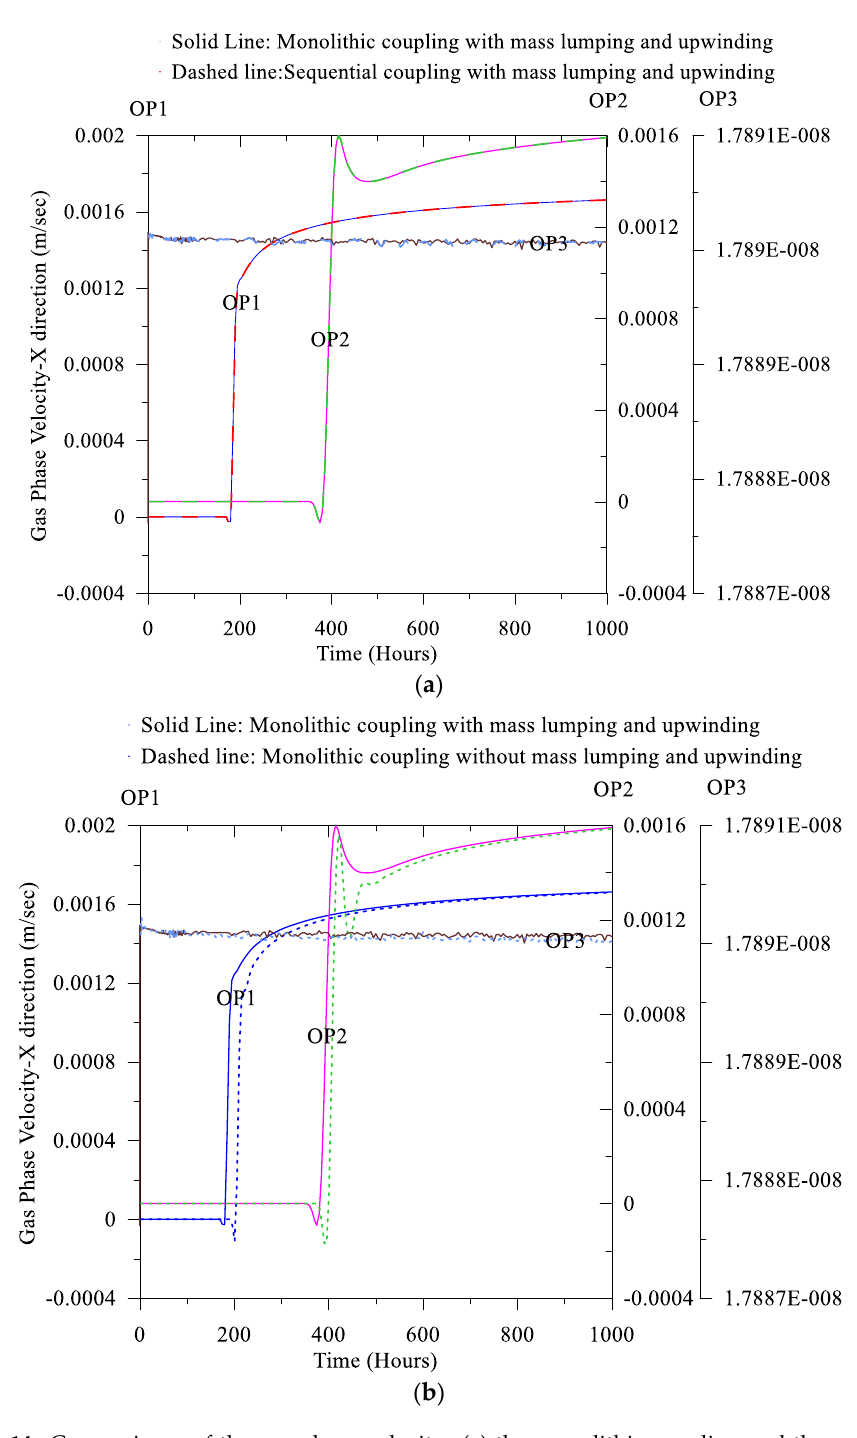
Figure 14. Comparisons of the gas phase velocity: ( a ) the monolithic coupling and the sequential coupling and ( b ) with and without the mass lumping and the upwinding.